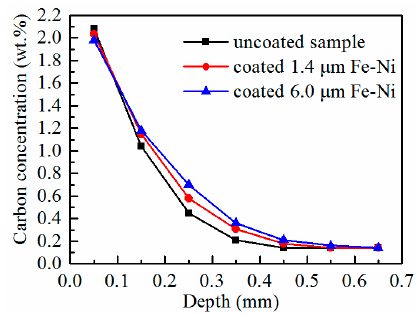
Figure 5. Carbon concentration profiles of the as-carburized samples.